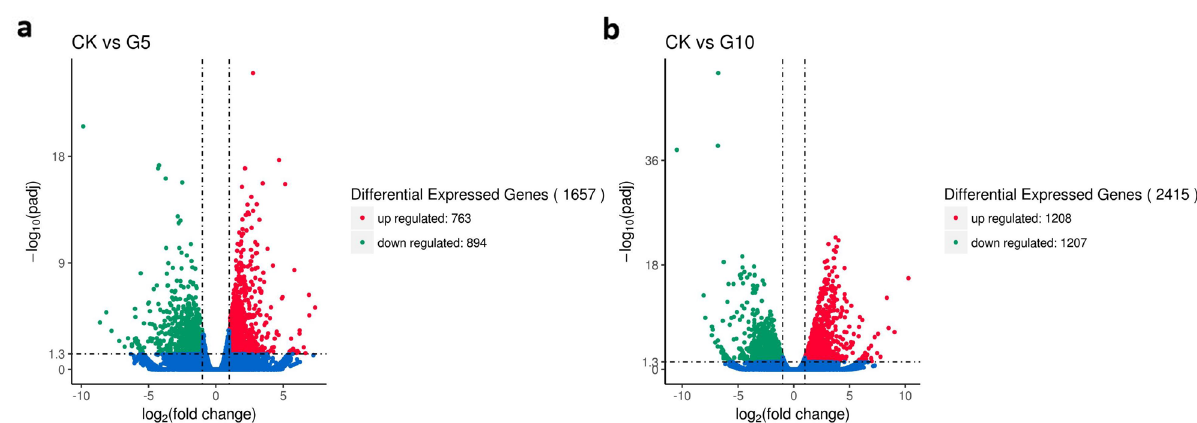
Figure 5. Comparison of DEGs in CK versus G5 and CK versus G10. ( a ) The differential expressed genes between CK and 5% 1-G4 treated BS. ( b ) The differential expressed genes between CK and 10% 1-G4 treated BS. X-axis represents the value of − log 10 (padj); Y-axis represents the value of log 2 (fold change): green spots represent down-regulated genes and the red spots represent the up-regulated